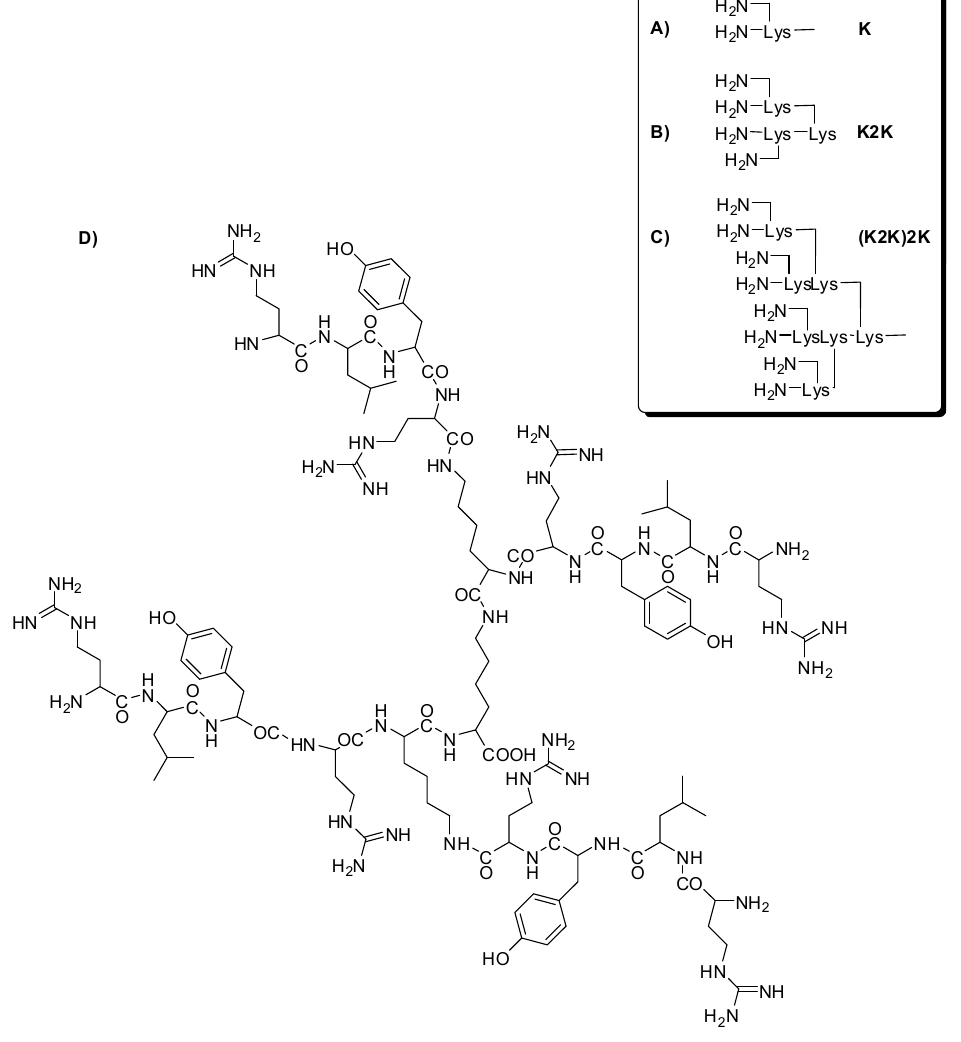
Figure 12. Peptide dendrimers for selective action in microbial surface [63].